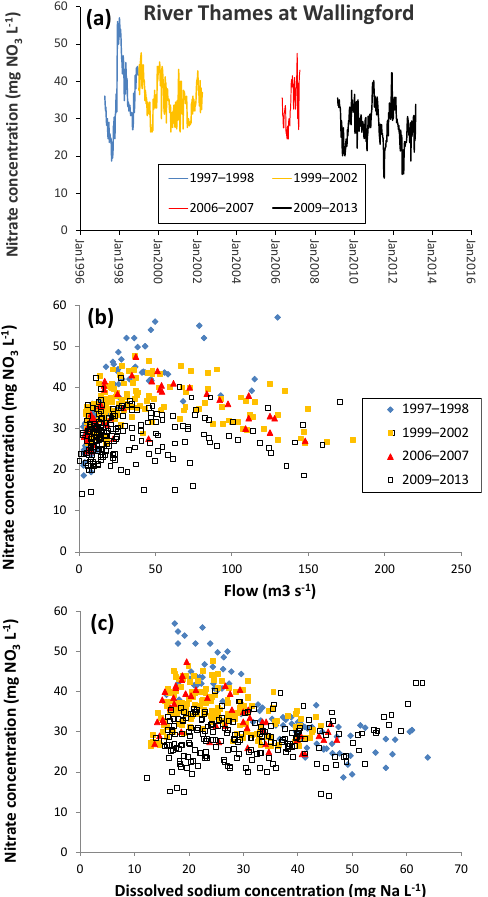
Figure 6. Changes in soluble reactive P concentration in the middle reaches of the River Thames at Wallingford from 1997 to 2013, as (a) a time series, (b) related to mean daily river flow and (c) related to sodium concentration.